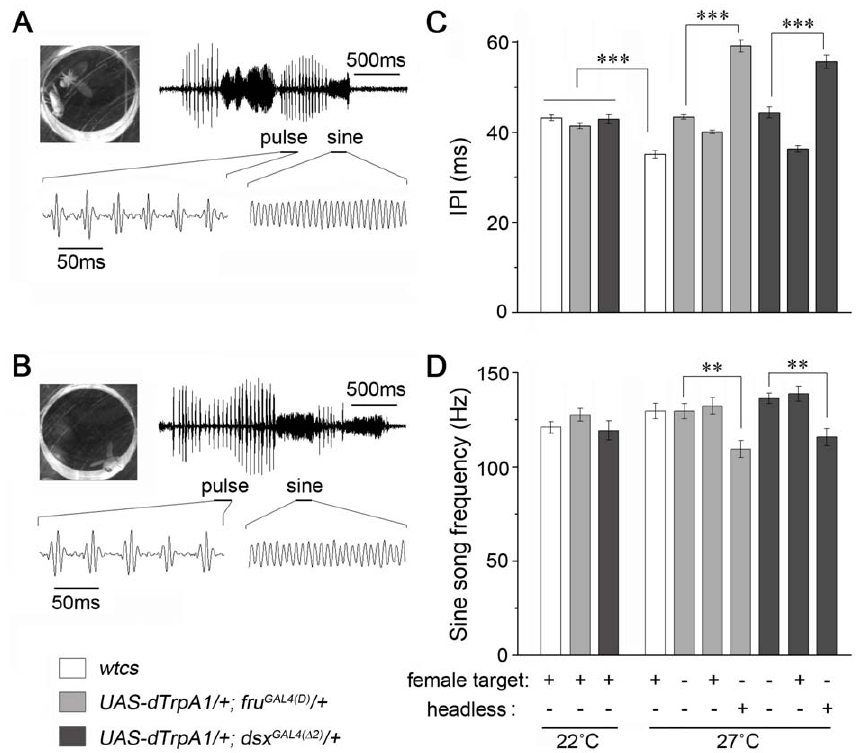
Figure 4. Courtship song properties of intact and headless males. (A–B) Courtship song samples from a pair of wild-type Canton S ( wtcs ) flies at 27 u C (A), and from a solitary male with all fru M neurons being activated ( UAS - dTrpA1 / + ; fru GAL4(D) / + ) (B). Both samples contain sine and pulse components. (C–D) Interpulse interval (IPI) of the pulse song (C) and frequency of the sine song (D). All male-female pairs tested at 22 u C showed no difference from each other, and their IPIs are higher than wild-type pairs at 27 u C ( p , 0.001, ANOVA). IPIs acquired in solitary males at 27 u C are also significantly higher than wild-type pairs (white) at 27 u C; further more, IPIs in headless males are higher than those in intact males ( p , 0.001 for both UAS - dTrpA1 / + ; fru GAL4(D) / + (light gray) and UAS - dTrpA1 / + ; dsx GAL4( D 2) / + (gray) males, two sample t-test). The introduction of a female target at 27 u C partially (to UAS - dTrpA1 / + ; fru GAL4(D) / + male) or fully (to UAS - dTrpA1 / + ; dsx GAL4( D 2) / + male) restored IPI to wild type level. Sine song frequencies were lower in headless males ( p , 0.01, two sample t-test). n =7–8 for each. ** p , 0.01 and *** p , 0.001. Error bars indicate